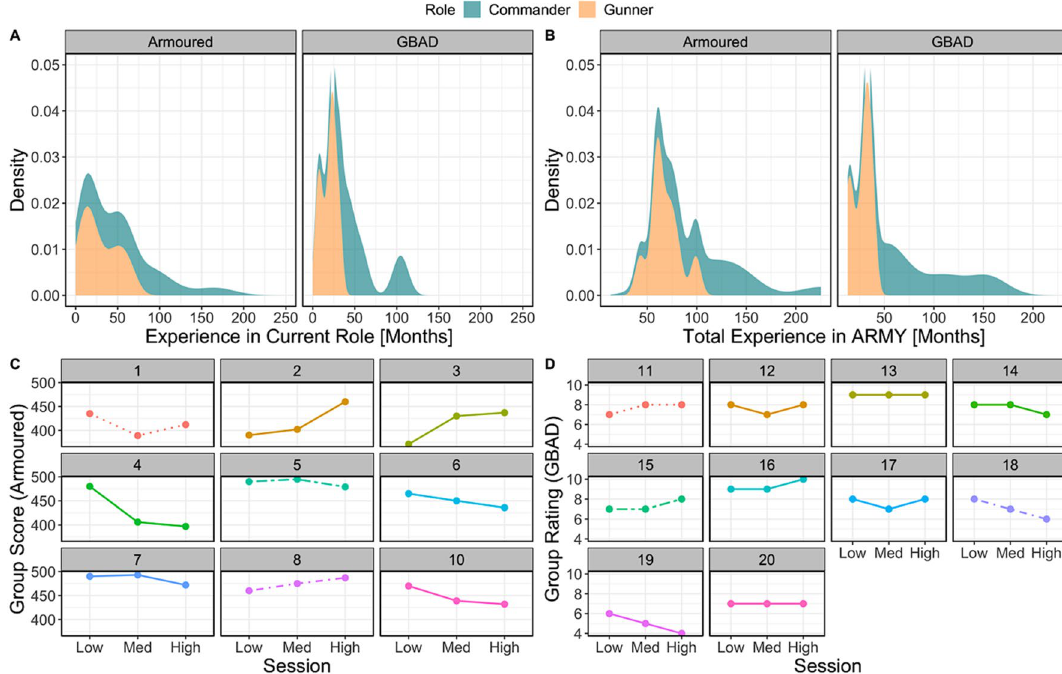
Figure 1. Summary of time served in the military and dyadic behavioural performance. ( A ) Summary of time (in months) in current role between gunners (orange) and commanders (blue) at Armoured (left) and GBAD (right), while ( B ) illustrates the same for total time in military service (months). ( C ) Performance scores for each dyad during the Armoured tank simulation task. Each facet represents a dyad (i.e., gunner and commander). Performance is represented on the y-axis (higher values indicate better performance), while session (one = low, two = med, three = high) is represented on the x-axis. ( D ) Subjective rating scores for performance for each dyad during the GBAD dome simulation task. Each facet represents a dyad (i.e., gunner and commander). Performance is represented on the y-axis (higher values indicate better performance), while training scenario (easy, moderate difficult) is represented on the